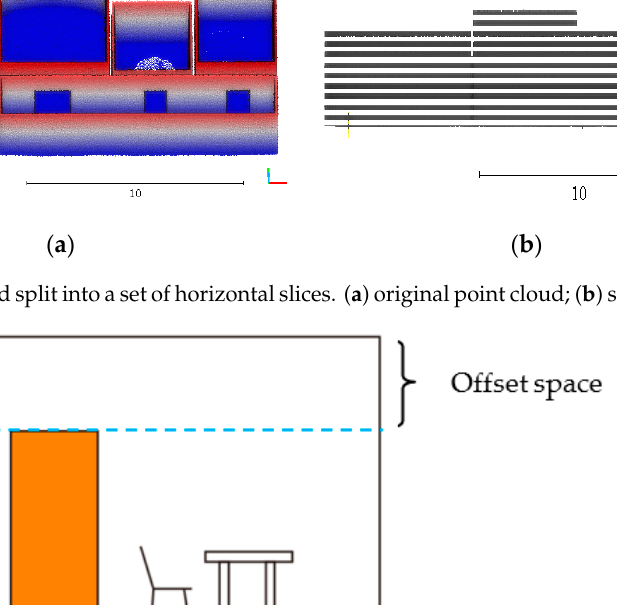
Figure 3. Objects on the floor. The offset space is determined by door height experientially.